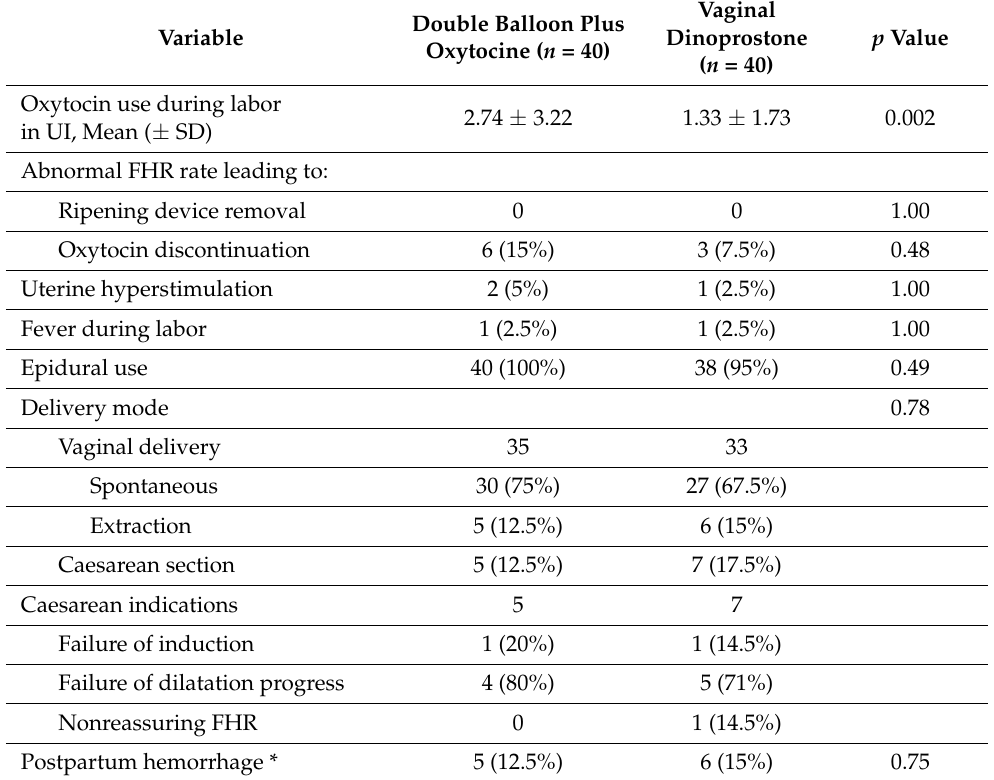
Table 3. Maternal outcomes.